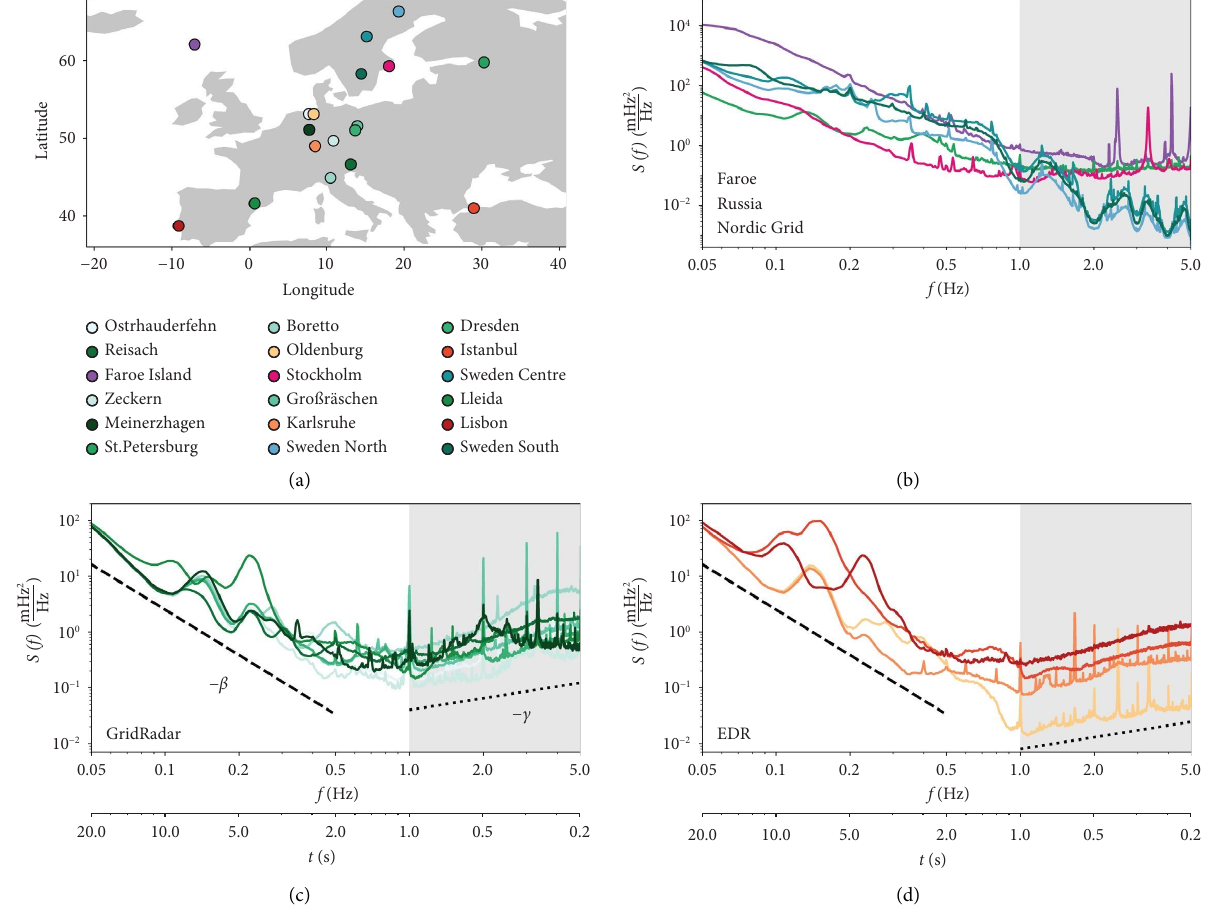
Figure 2: Power-grid dynamics change qualitatively at the 1-second time scale. We utilize recordings from various locations in Europe (a) to then plot the spectral density S ( f ) of the power-grid frequency (b)–(d). Tis analysis includes independent synchronous areas (b) as well as Continental Europe data obtained from grid radar (c) and from the EDR (d). Note that we plot S ( f ) and also report the corresponding time scales t � 1/ f . While all recordings initially display an approximately decaying power law β , several recordings display a rising spectrum with slope c for time scales below t ∼ 1 s .